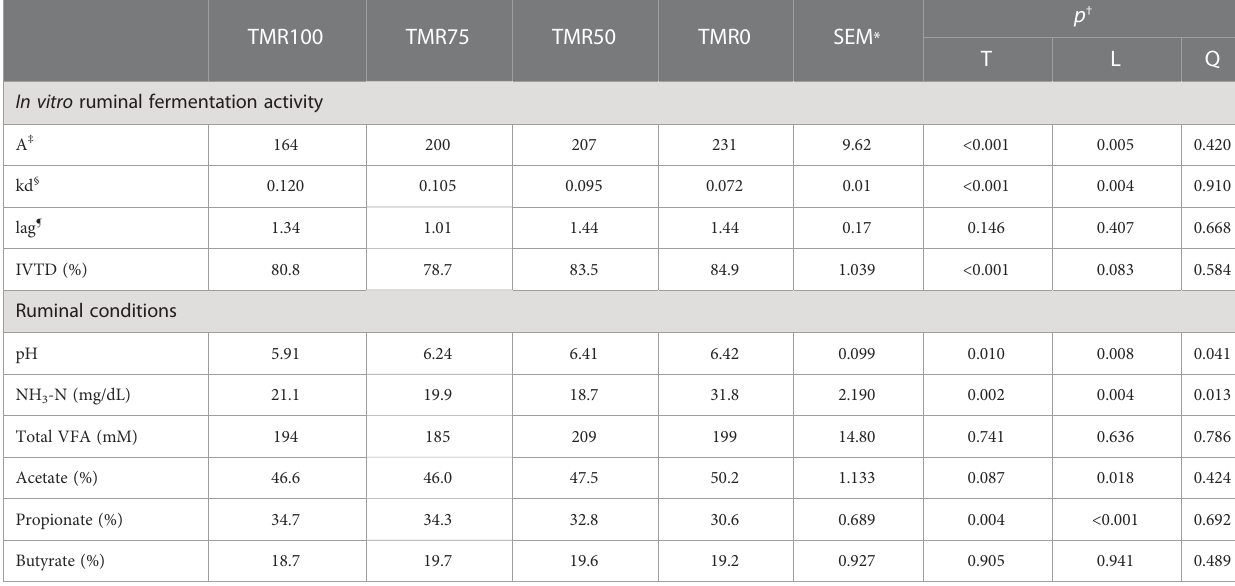
TABLE 2 In vitro gas production parameters and true digestibility (IVTD) using ruminal liquor of lambs fed total mixed rations (TMRs) (TMR100), 75% TMR and alfalfa (TMR75), 50% TMR and alfalfa (TMR50), or only alfalfa (TMR0) as inocula, and ruminal liquor conditions at the same hour of the inocula extraction (pH values and NH 3 -N and VFA